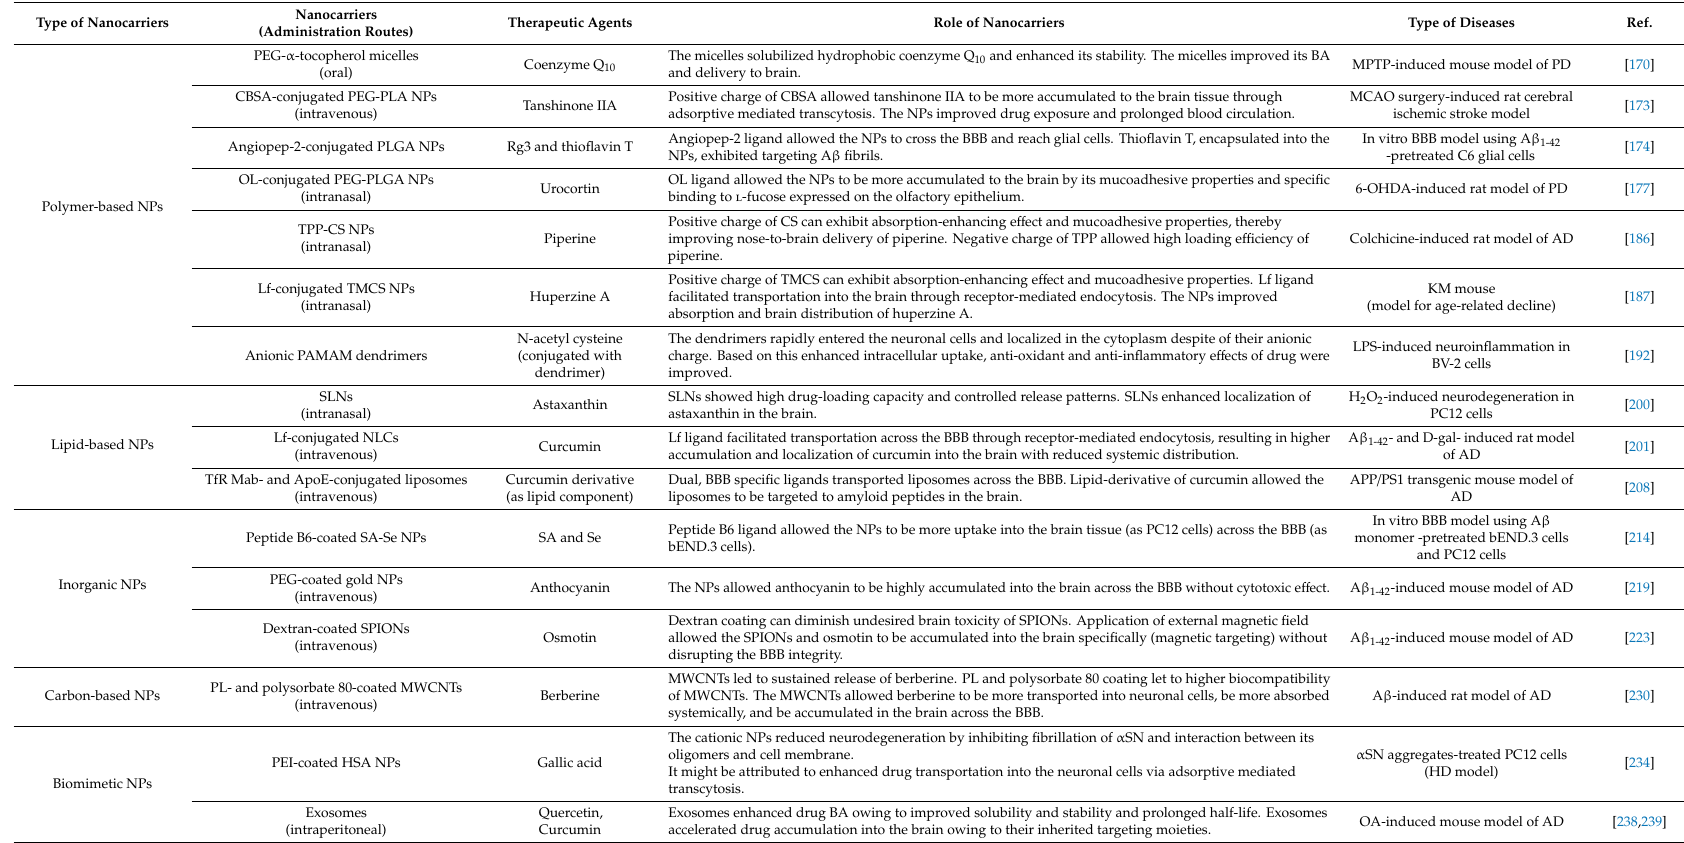
Table 3. Various nanocarriers for enhanced therapeutic e ff ects of natural compounds on CNS